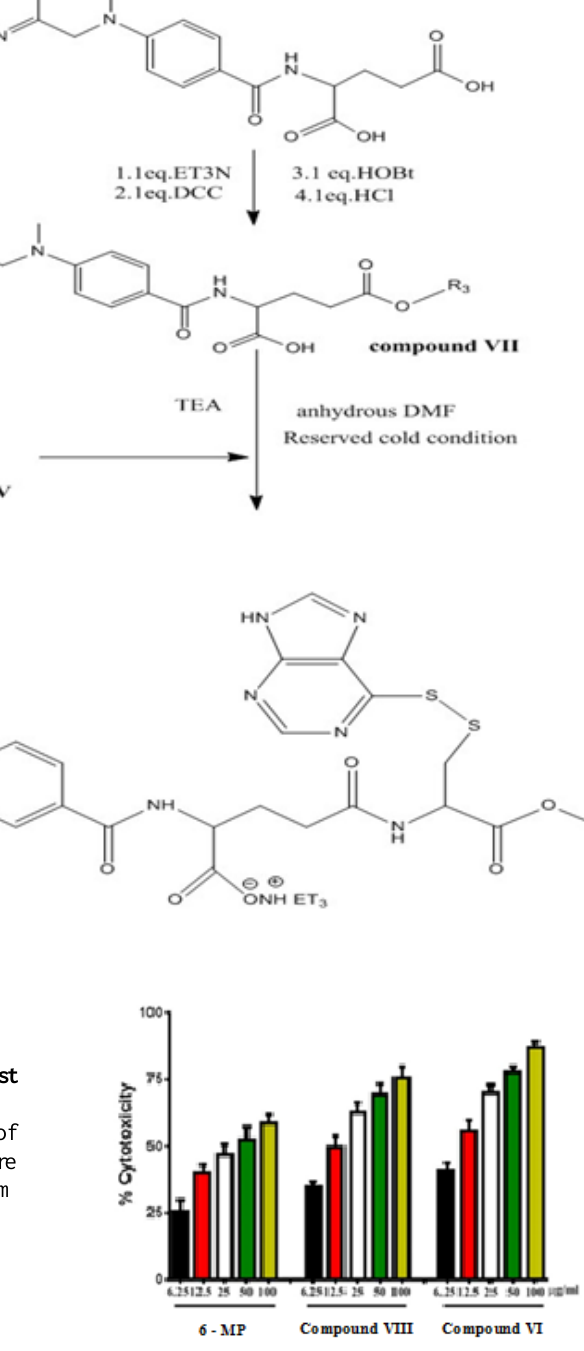
Figure (1) Cytotoxic activity of 6MP, compound VI, VIII against MCF-7 cell